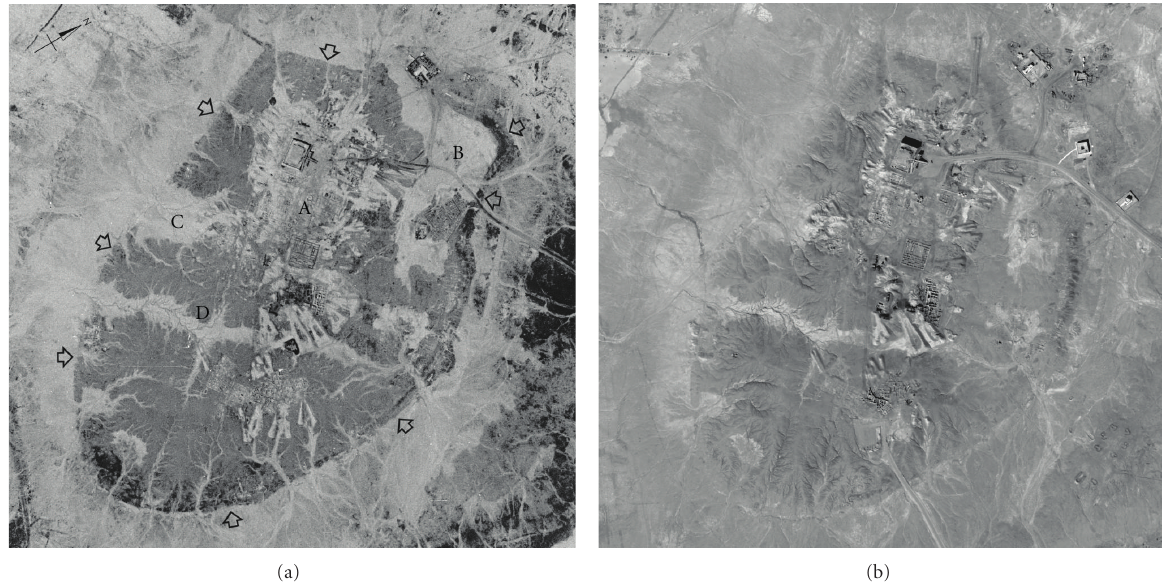
Figure 3: The hill of Ur in a Gambit KH-7 photograph taken in April 1966 and in a WorldView-1 image acquired in March 2008: A: the sacred area with the Ziggurat and the other main monuments; B: the North Harbour; C: the West Harbour, a depression that probably corresponds to an ancient channel. The arrows indicate traces and remains of the city